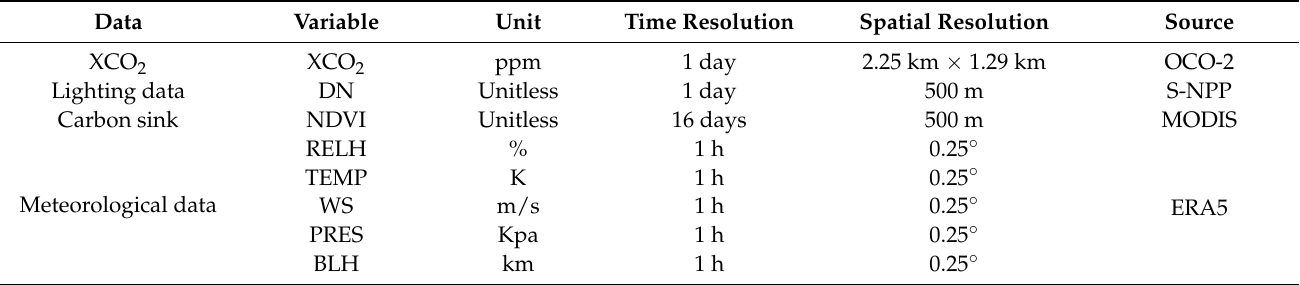
Table 1. Data sets used in this study.